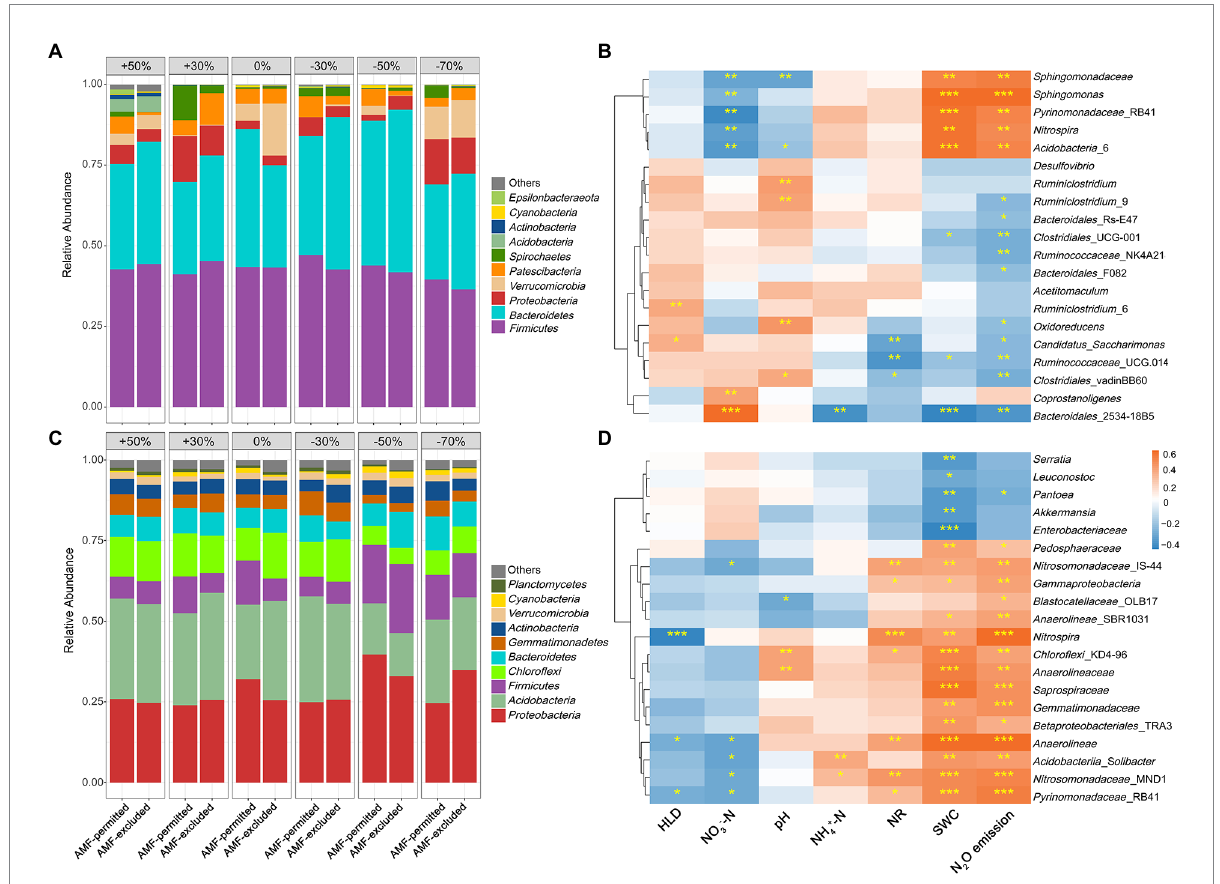
FIGURE 4 Phylum-level microbial composition of soils under AMF-permitted and AMF-excluded in different precipitation conditions in 2019 (A) and 2020 (C) . Heatmap of correlation of Bray-Curtis distances of the microbial abundance and soil properties at the level of operational taxonomic units (97% DNA sequence identity) for 2019 (B) and 2020 (D)